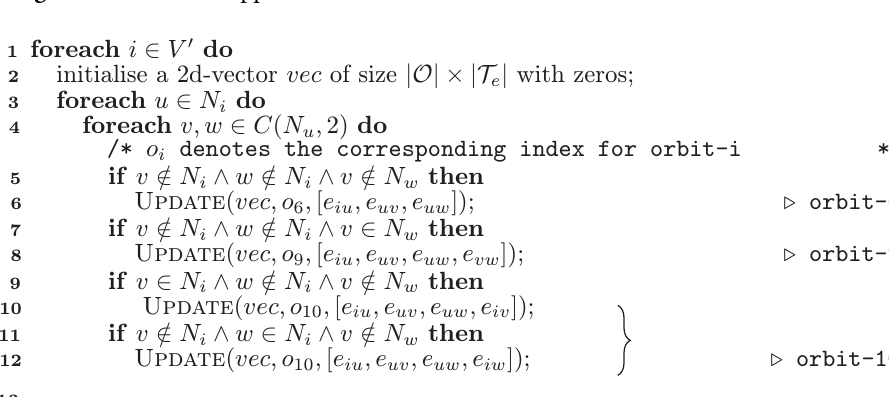
Algorithm 3: Code Snippet for Orbit-6, 9 and